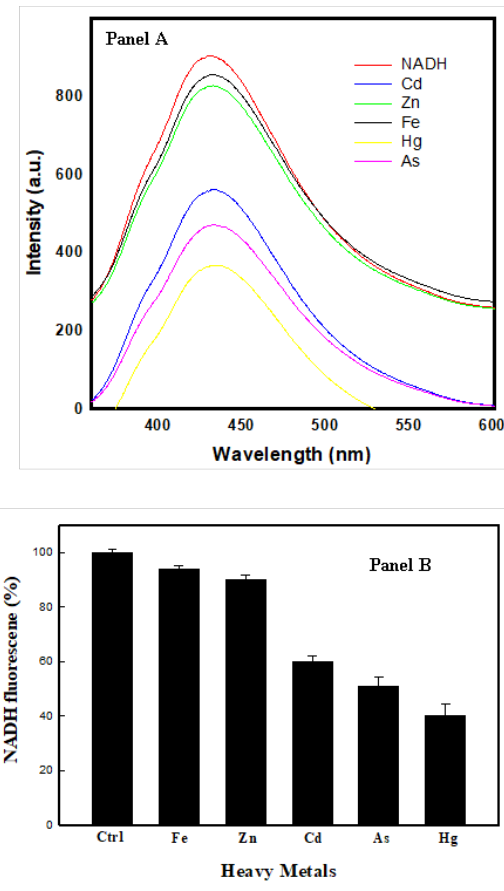
Figure 6. ( Panel A ) Fluorescence spectra of NADH (Nicotinamide adenine dinucleotide hydrogen) alone and treated with di ff erent heavy metals (5 M). ( Panel B ) Inhibition of fluorescence in the absence and presence of toxic